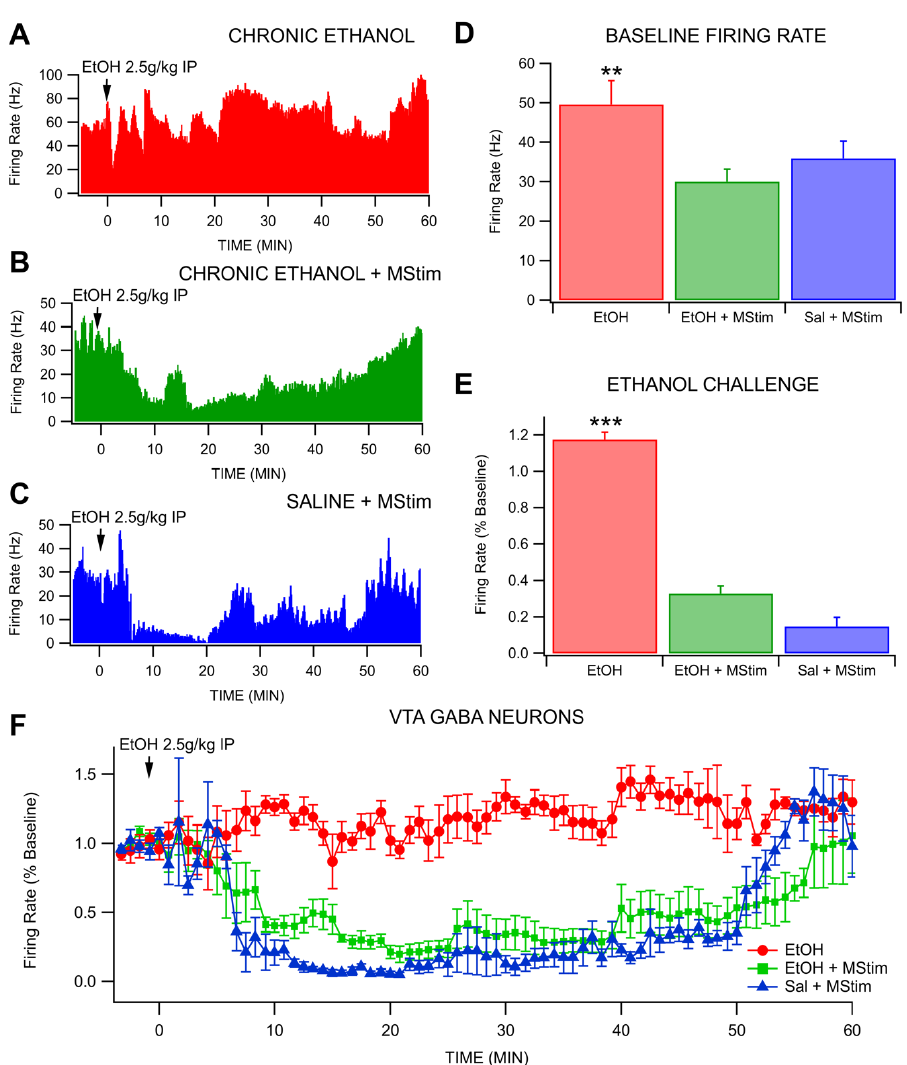
Figure 2. Effects of MStim on VTA GABA neuron firing rate after reinstatement ethanol during withdrawal. ( A – C ) Representative traces for GABA neuron response for ( A ) EtOH alone, ( B ) EtOH + MStim and ( C ) saline + MStim. ( D ) Baseline firing rate differences between the three groups. Note that EtOH alone maintained a higher baseline firing rate. ( E ) MStim blocks chronic EtOH-induced desensitization of GABA neurons to EtOH reinstatement. ( F ) Time course data with 50 s bins demonstrating disparate effects among groups. Asterisks (**, ***) indicate significance levels p < 0.01 and 0.001, respectively.